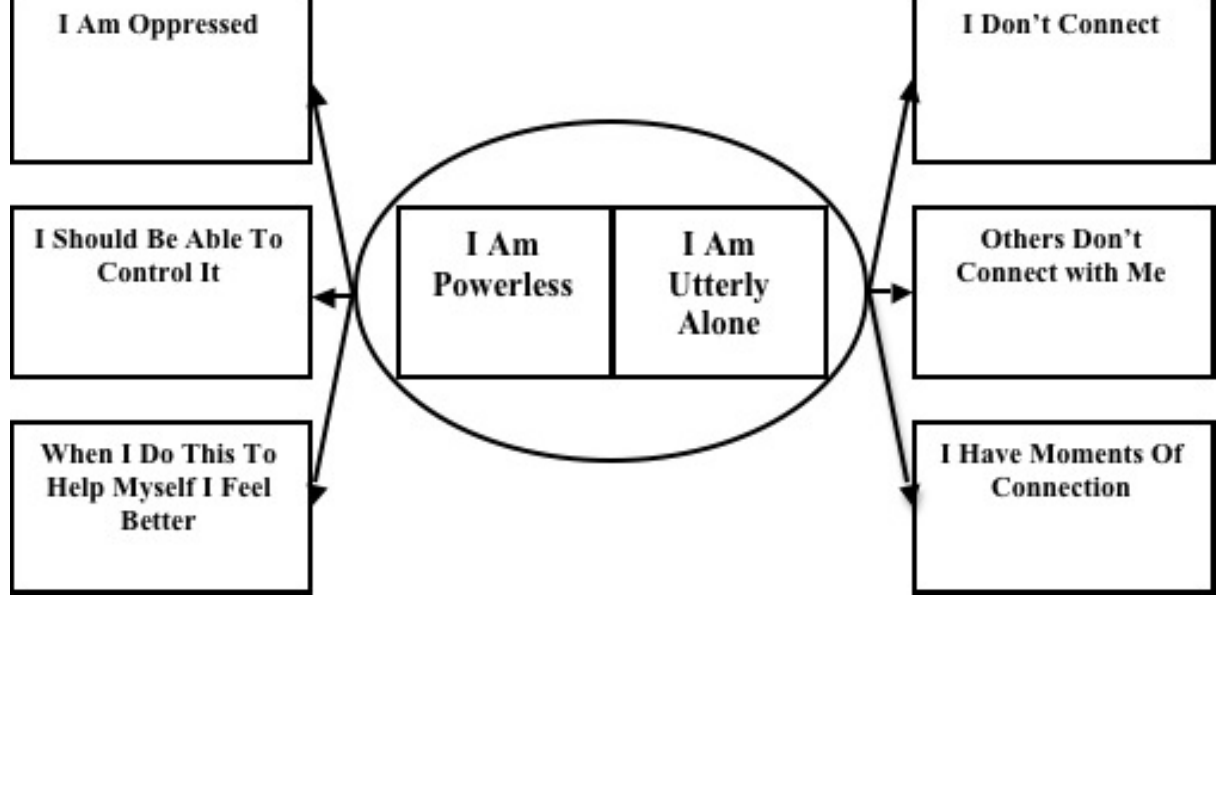
Figure 1. Emergent model of bloggers’experience of a mental health